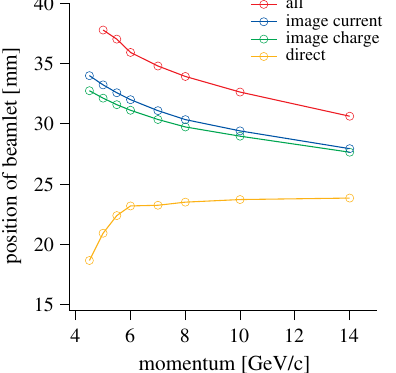
FIG. 13. Beamlet ’ s position for a beam kicked into a stable island. Two different electric boundary conditions have been < 0 ¼ 6 . 262 . The beam momentum < 0 and Q used. In this case h 2 ; 0 ; 0 x is 14 GeV =c